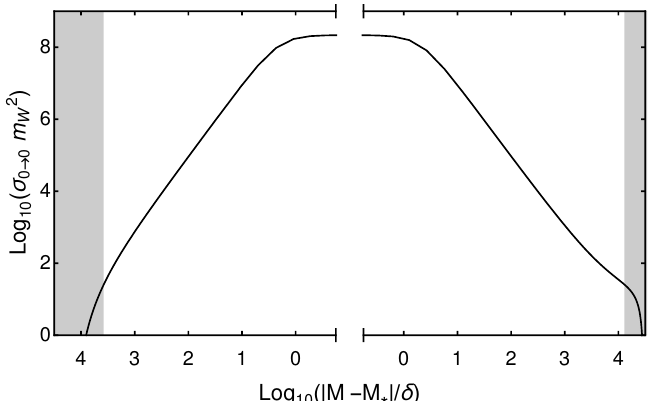
Figure 6 . Log-log plot of the neutral-wino elastic cross section (cid:27) 0 ! 0 at zero energy as a function of the wino mass M near the unitarity mass M (cid:3) = 2 : 39 TeV. The horizontal axis is the logarithm of j M (cid:0) M (cid:3) j =(cid:14) , with M increasing to the right towards M (cid:3) on the left side of the plot and increasing to the right away from M (cid:3) on the right side of the plot. The grey regions are the ranges of M in which (cid:27) 0 ! 0 < 8 (cid:25)=m 2 , so a ZREFT for neutral and charged winos is not applicable. W A log-log plot of the zero-energy cross section as a function of M is shown in (cid:12)gure 6. There are scaling regions of M just above and below M where the cross section scales (cid:3)